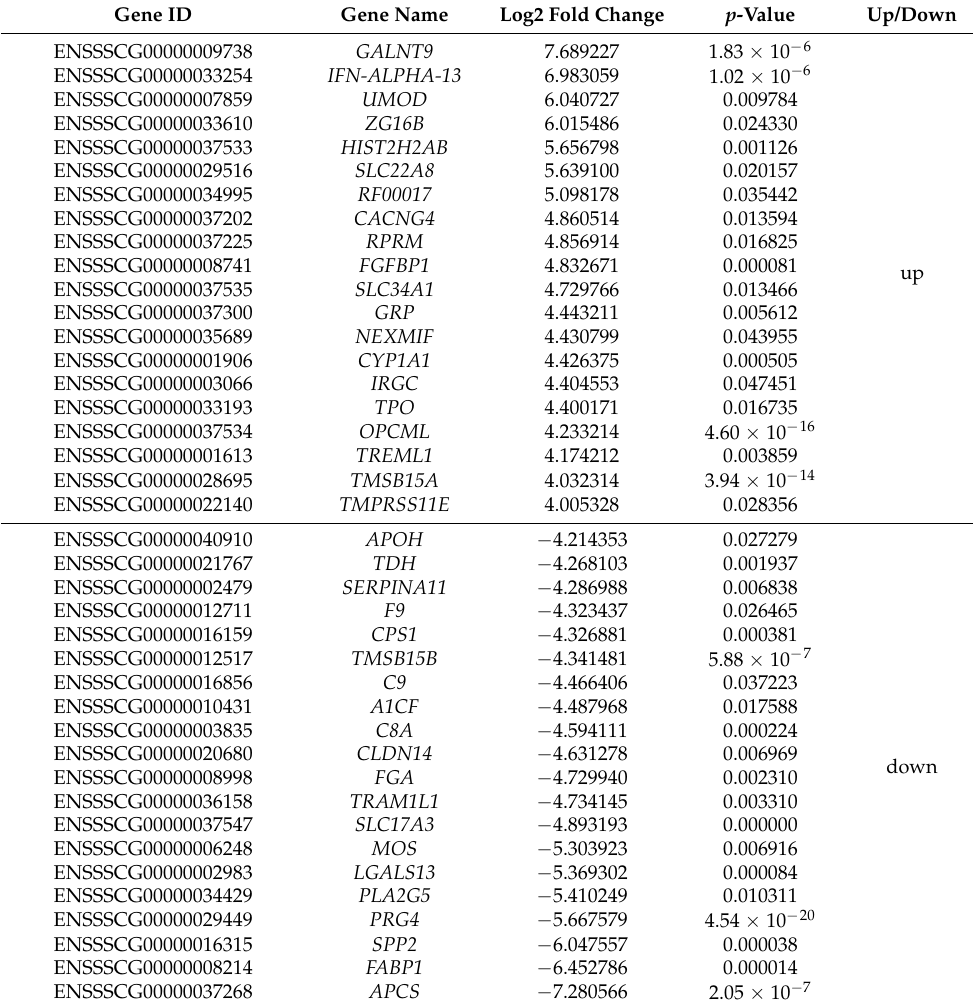
Figure 1. Cluster analysis of differentially expressed genes. Venn diagram of the number of genes expressed in each group ( A ); heatmap of differentially expressed genes between the two groups ( B ); volcano plot of differentially expressed genes ( C ); and differentially expressed genes ( D ). YY, Yorkshire pig; TP, Tibetan pig. Table 1. Detail information for the top 20 differentially expressed genes.